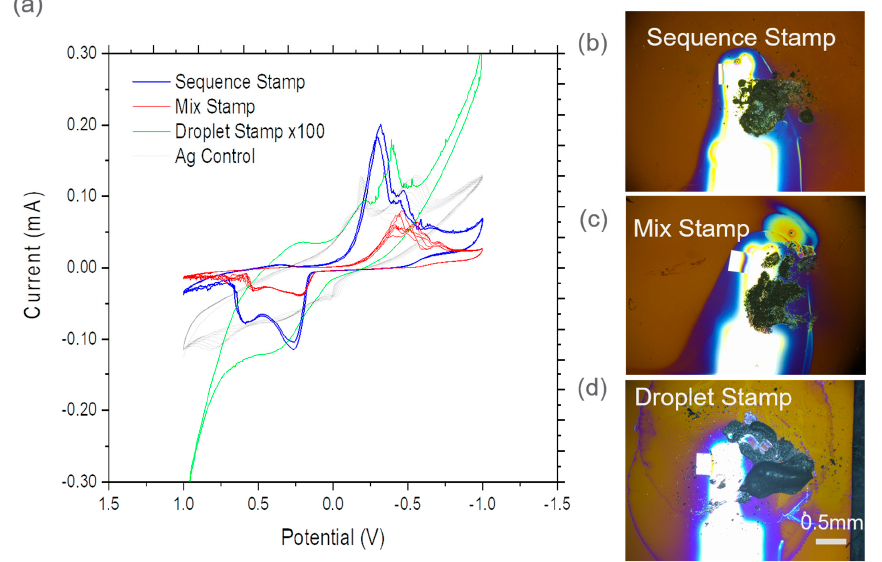
Figure 5. ( a ) CV comparisons of WE surfaces containing graphite nanoparticles using three stamping methods and the control device and optical microscope image of ( b ) sequence stamping, ( c ) mixing and stamping; and ( d ) droplet spraying and stamping. The shining finger-like feature in ( b – d ) is the Au conductive layer.